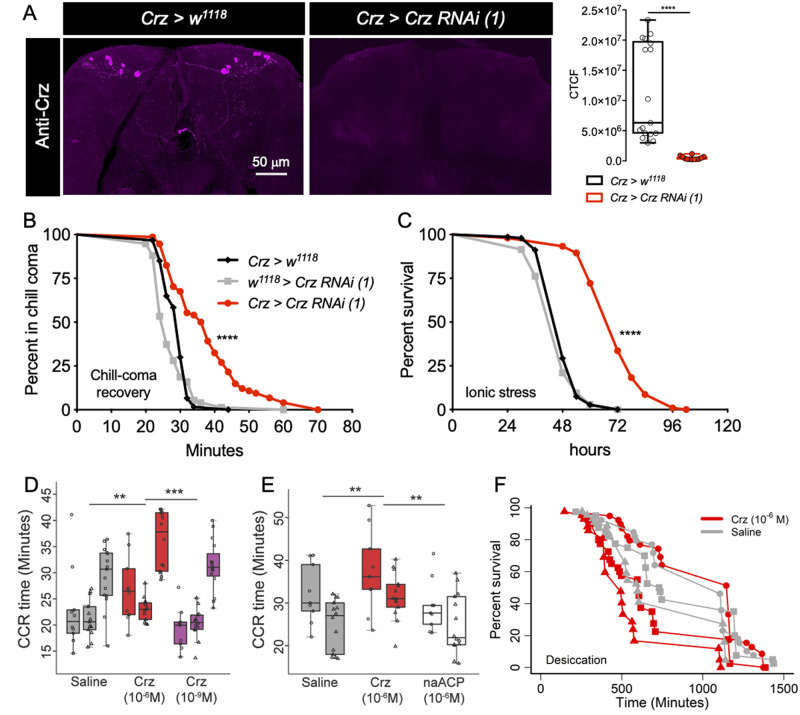
Crz signaling influences osmotic and ionic stresses.(A)
Crz1-GAL4 driven Crz-RNAi (1) causes a significant decrease in anti-Crz staining (corrected total cell fluorescence, CTCF) in the brains of adult Drosophila (**** p < 0.0001 as assessed by unpaired t-test). (B)
Crz knockdown results in a significant delay in recovery from chill-coma and (C) increased survival under ionic stress. For B and C, data are presented as survival curves (**** p < 0.0001, as assessed by Log-rank (Mantel-Cox) test). Crz peptide injections in vivo influence (D, E) chill-coma recovery and (F) desiccation survival. (D) Low dose (10-9M) of injected Crz has no effect whereas a high dose (10-6M) of Crz delays chill-coma recovery (** p < 0.01, *** p < 0.001 as assessed by two-way ANOVA). (E) A non-active exogenous peptide (10-6M), non-amidated Aedes adipokinetic hormone/corazonin-related peptide (naACP), has no effect on chill-coma recovery (** p < 0.01 as assessed by two-way ANOVA). In D and E, the y-axes (Time) represents the chill-coma recovery (CCR) time. (F) We used a Cox proportional hazards model to test whether injection of 10-6M Crz (red lines) influences the rate of death under desiccation conditions compared to saline injection (grey lines), while accounting for any time-effects (different time points are indicated using circle, triangle and square symbols). Crz injection increases the risk of death by 40% compared to control flies. This difference is statistically significant at p = 0.0003. Two independent trials for E and three independent trials for D and F were performed. These trials are indicated using different symbols (circle, triangle and square).